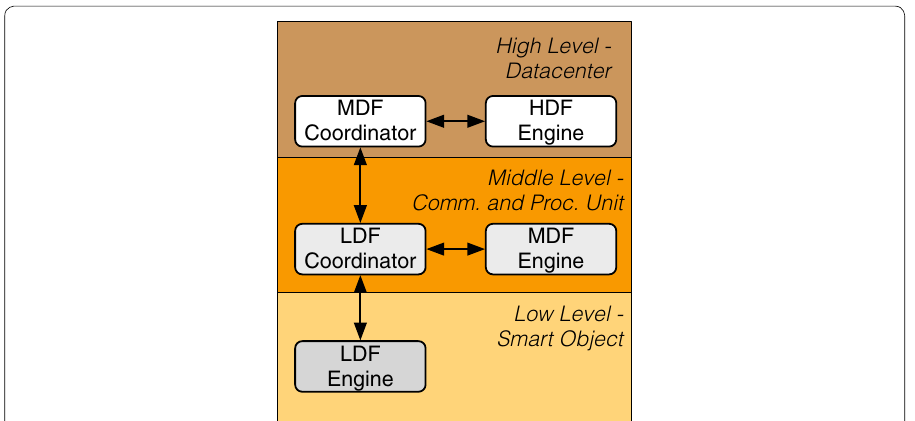
Fig. 2 Conceptual architecture of the multi-level hierarchical data fusion for digital healthcare ecosystems. This figure illustrates the proposed approach at a conceptual level and depicts how data fusion levels interact with each other